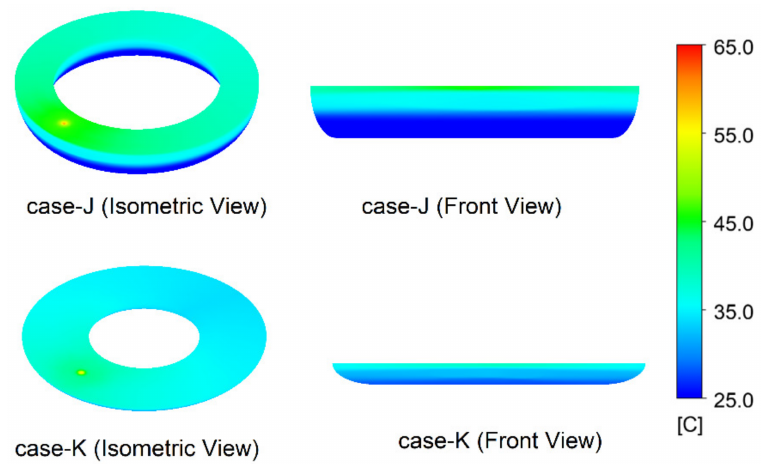
Figure 15. Temperature variation by the end of 3600 s for cases with an aspect ratio of 0.5 (Case J) and 2.0 (Case K).